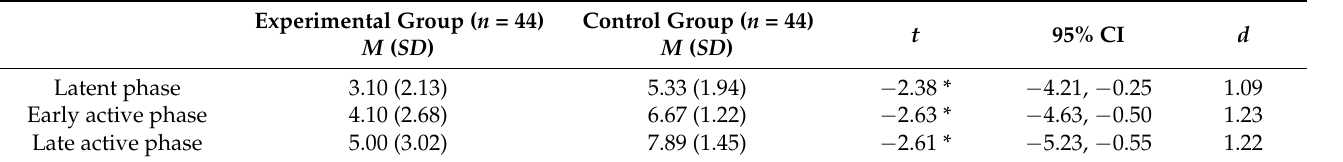
Table 3. Comparisons between experimental and control groups on anxiety measured with VAS-A during the stages of labor.